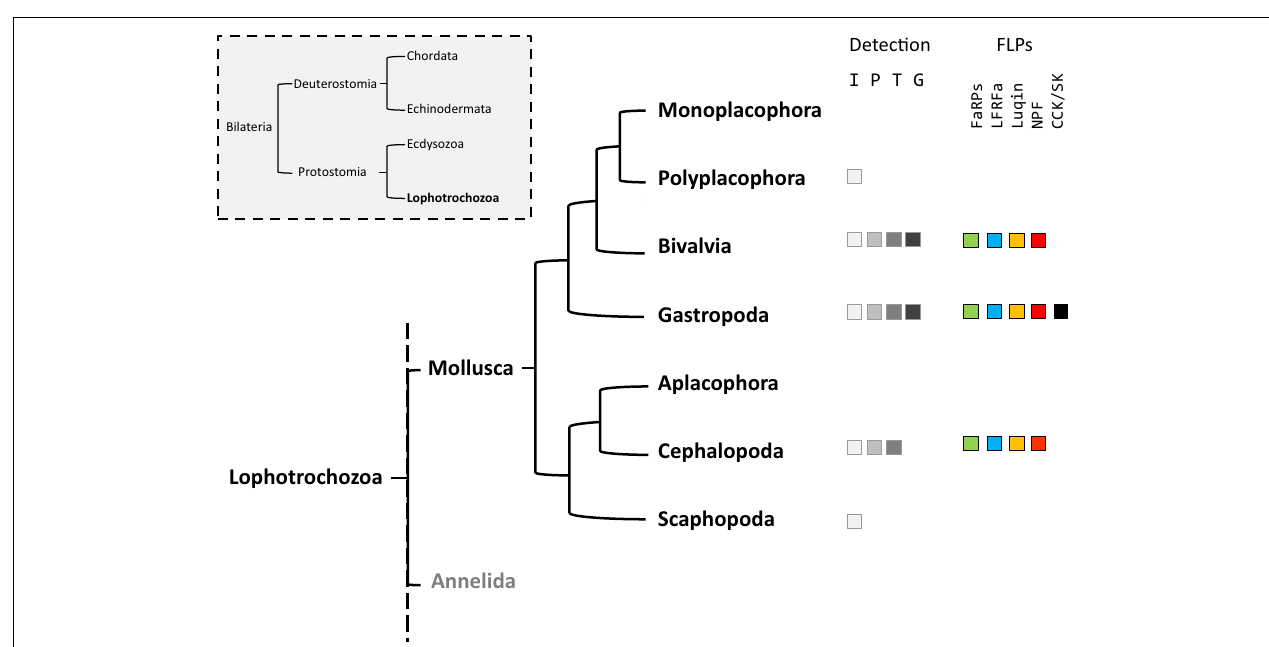
FIGURE 1 | Phylogenic tree of mollusks based on Stöger et al. (1) .The occurrence of the different FMRFamide-like peptides (FLPs) in each class is detailed. F a , FMRFa-related peptides or FaRPs; L r , LFRFamide peptides; L u , Luqin; N p , NPF; C ck , cholecystokinin-/sulfakinin-like peptides.The methodologies used for FLPs detection are indicated: I, immunohistochemistry; P, peptide identification;T, transcript characterization; G,